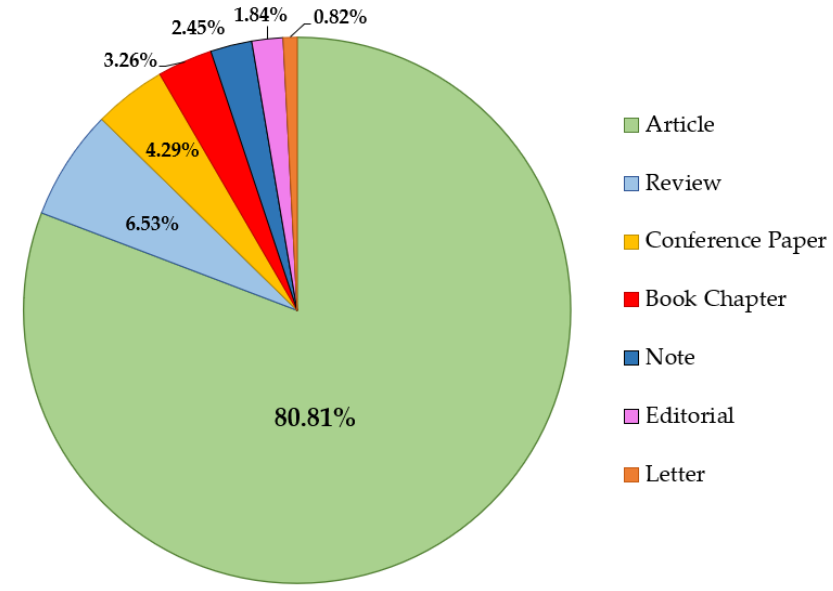
Figure 4. Document types associated with socio-hydrology.